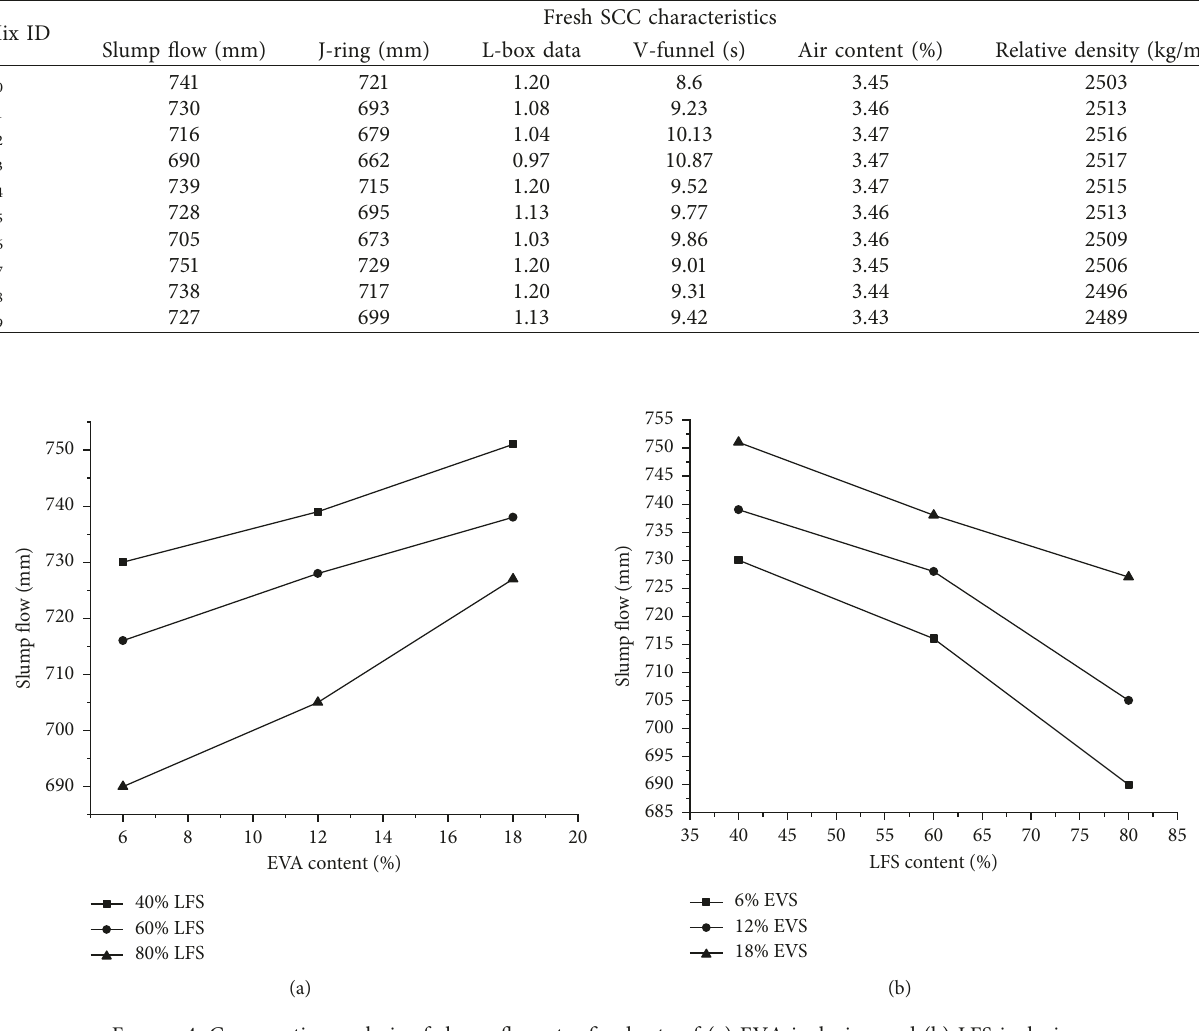
Figure 4: Comparative analysis of slump flow at a fixed rate of (a) EVA inclusion and (b) LFS inclusion.